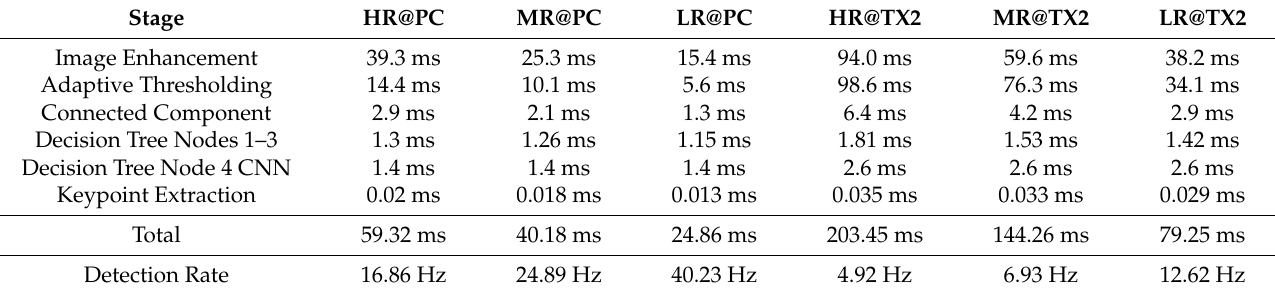
Table 7. Processing time evaluation on the desktop PC and TX2